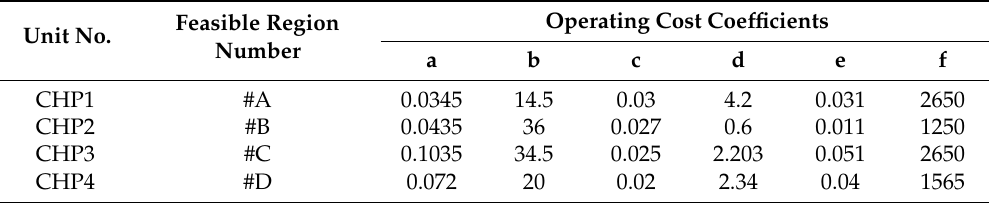
Table 3. Parameters of CHP units.